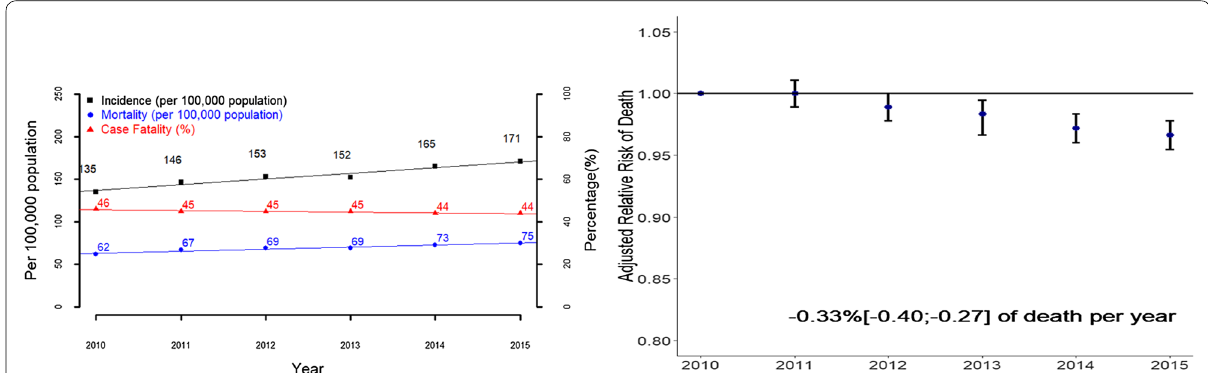
Fig. 3. Incidence, mortality, case fatality from 2010 to 2015 in the whole cohort of patients with septic shock ( a ) and adjusted relative risk of hospital death rate from 2010 to 2015, in the whole cohort of patients with septic shock ( b ). The adjusted relative risk of hospital death was based on the adjusted odd ratio of death obtained by a multivariate hierarchical logistic regression analysis with a random center effect taking into account all the associated factors of hospital death (Additional file 1: Table